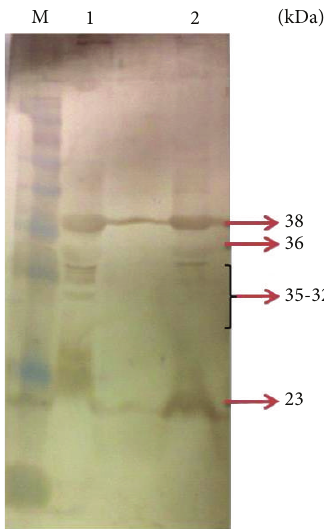
Figure 3: Immunodominant outer membrane proteins of Pas- teurella multocida B:2 in apparently normal animal sera. Lane M: protein marker (250–15 kDa). Lane 1: immunodominant protein in normal condition. Lane 2: immunodominant proteins in iron- limited condition.